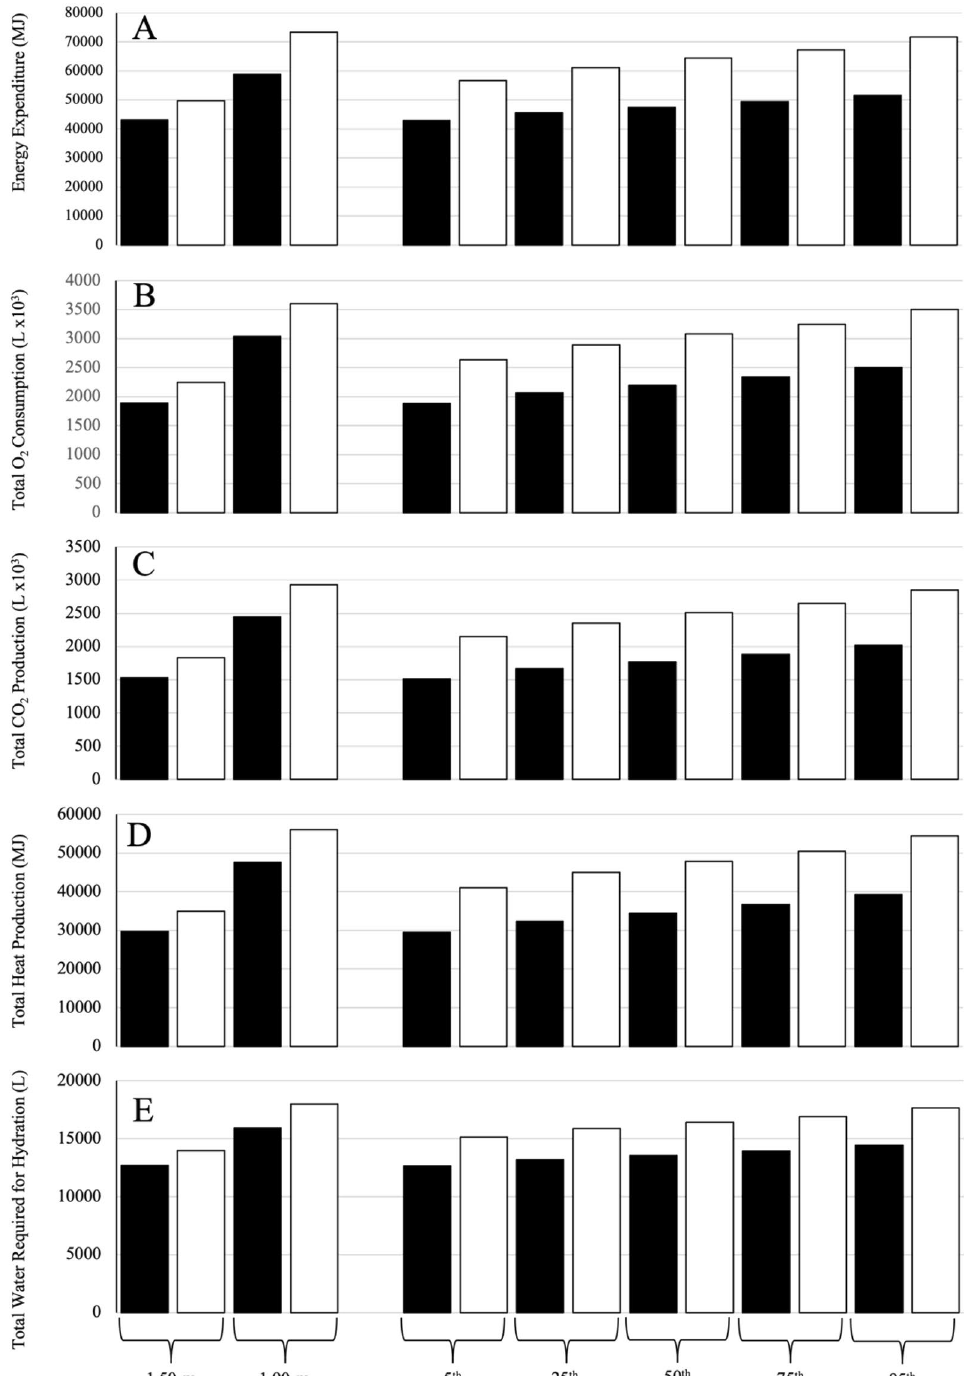
Figure 1. Energy expended ( A ), oxygen ( B ) consumed, carbon dioxide ( C ) and heat ( D ) produced, and water required for hydration ( E ) for all-female (black bars) and all-male (white bars, see 9 crews of different statures during a 1080-day mission using aerobic countermeasure exercise. The left portion of the figure shows female and male data when compared at absolute statures of 1.50-m and 1.90-m, the right portion shows data when compared at the 5th, 25th, 50th, 75th and 95 percentile for stature for United States (US) females and males based on the US Centre for Disease Control (CDC) 2015–2016 National Health and Nutrition Examination Survey (NHANES) 28